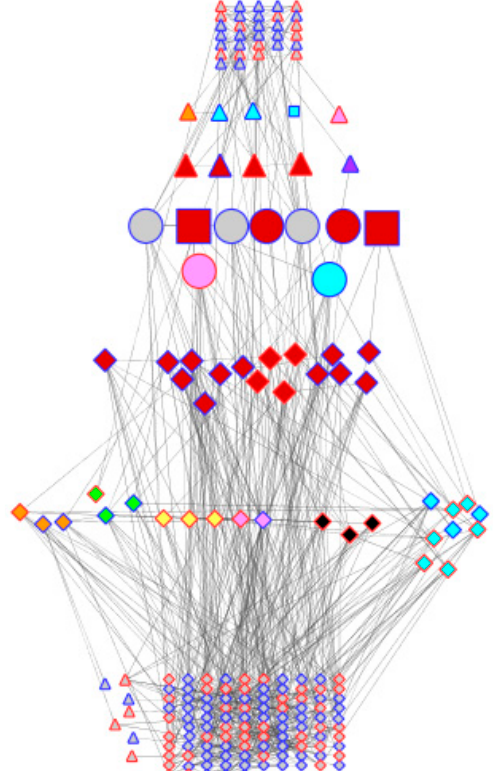
Figure 4. Comparison of genotype co-expression networks. Cytoscape has been used to layout the merged dehydration-responsive network of co-expressed probe-sets. Node shapes are triangles, diamond circles, and squares, respectively, for the differential expression of the probe-sets of TN, DipC, both (i.e., common), and both but affecting stomata. They have been coloured according to their activity in relation to the dehydration response: red (transcription), orange (cell wall), yellow (lignin synthesis), green (photosynthesis), blue (transporters), indigo (hormone signalling), pink (osmoprotection), black (oxidative stress), and grey (others). Node borders have been coloured red and blue to denote up- and downregulation under stress. Nodes have been arranged in seven horizontal bands with probe-sets in common in the middle flanked by TFs and hormone-signalling genes, other genes that play various roles in response to dehydration, and others. Nodes have been linked by the criteria of the co-expression analysis.